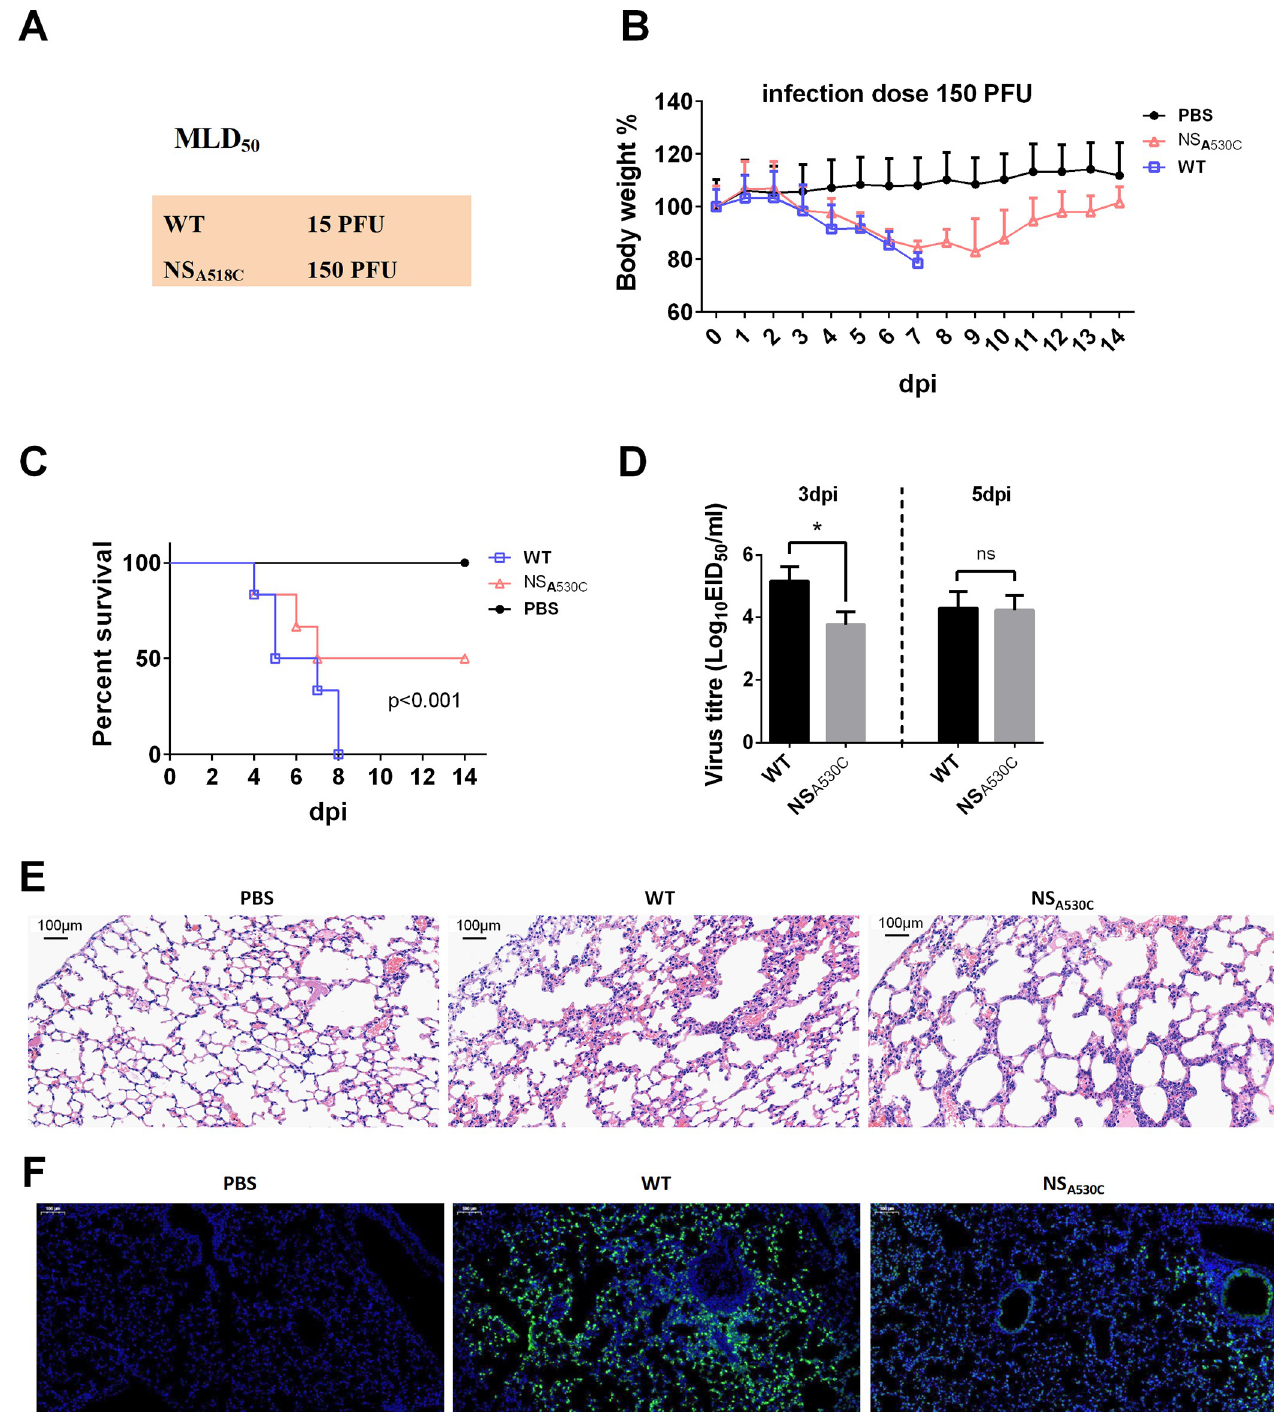
Fig 6. NS A530C mutation inhibited virus virulence. (A) MLD 50 of WT and mutant viruses. MLD 50 was calculated by the Reed and Muench method. (B and C) Weight loss and mortality of mice infected with each indicted virus. The body weight of the WT and mutant groups was compared and statistically analyzed. Error bars represent means ± SEM (n = 10). Statistical analysis of (C) was performed by using Log-rank (Mantel Cox) test. (D) Virus titers in the lungs of infected mice (n = 3) at 3 days (left) and 5 days (right) post-infection. Error bars represent means ± SEM. Statistical analysis was performed by using the one- way ANOVA method (n = 3, ns, not significant; * , P < 0.05). (E) Pathological lesions in the lungs of mice infected with the indicated virus at 3 days post- infection with hematoxylin and eosin (H&E) staining. Scale bars, 100 μ m. (F) Immunofluorescent staining of lung sections of mice infected with the indicated virus at 3 dpi. The viral NP antigen was stained green, and the nucleus was stained blue. Scale bars, 1000 μ m.